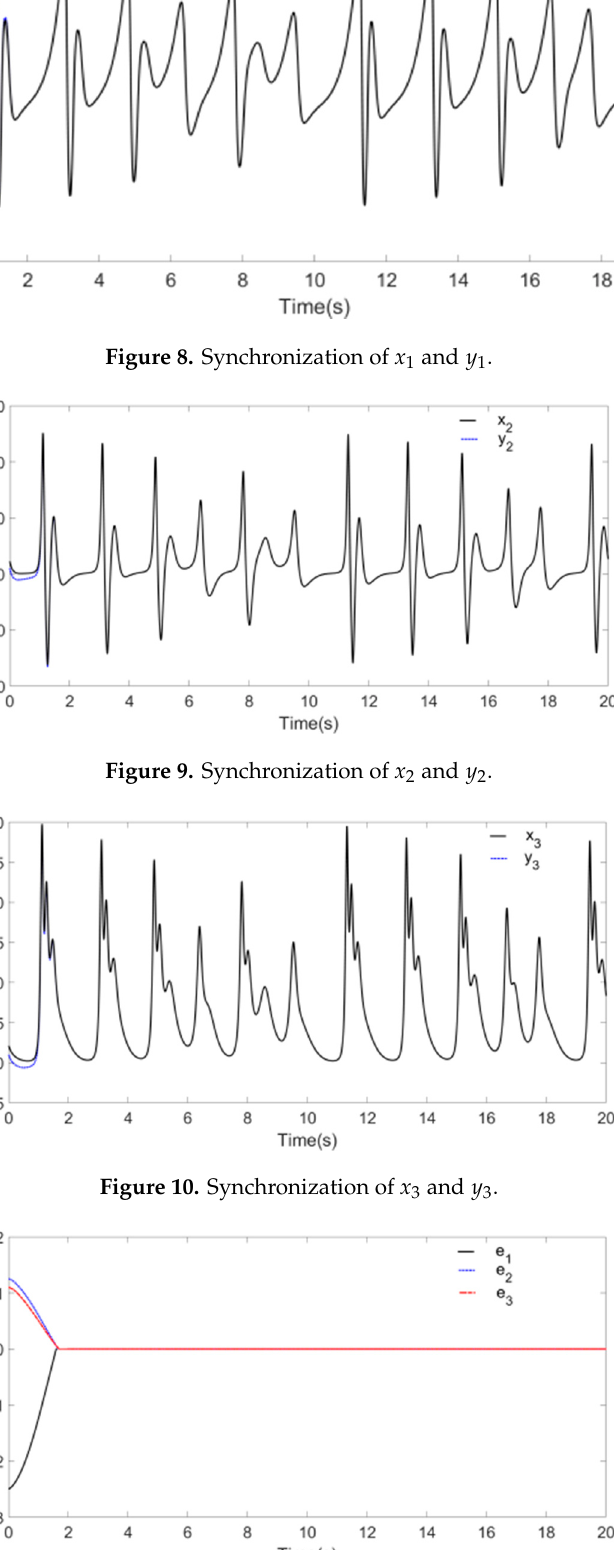
Figure 12. Identification process of